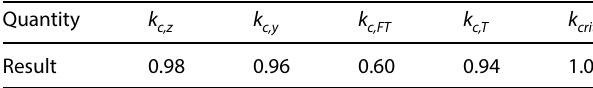
Table 4 Results of the interaction formulae the roof beam Flexural Interac- buckling tion formula